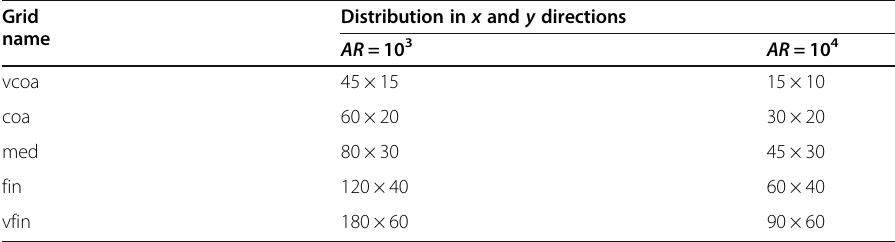
Table 2 Distribution of background quadrilateral grids in x and y directions Grid